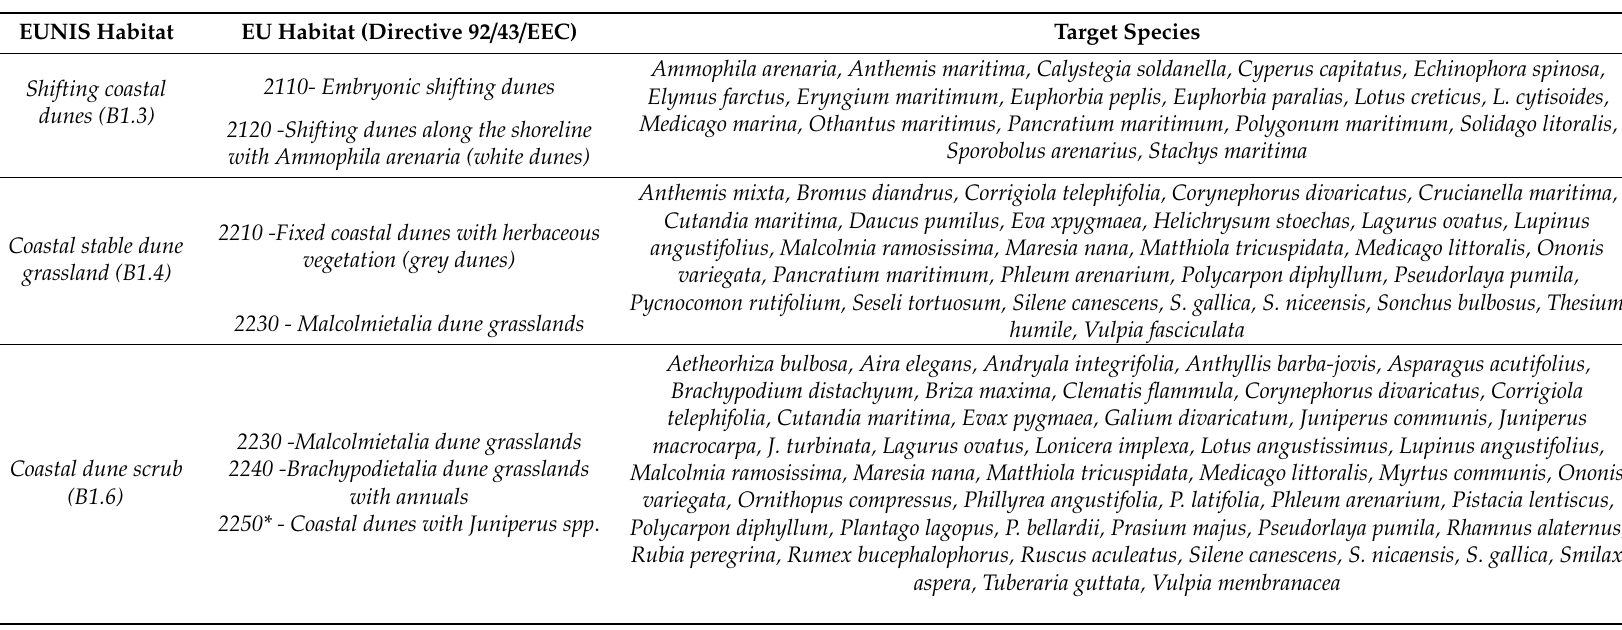
Table 1. The three EUNIS habitat types with corresponding EU Habitats. For each EUNIS habitat type, the target species are indicated according to the Italian interpretation manual of the Habitats Directive [28]. Asterisk denotes priority habitats according to Habitats